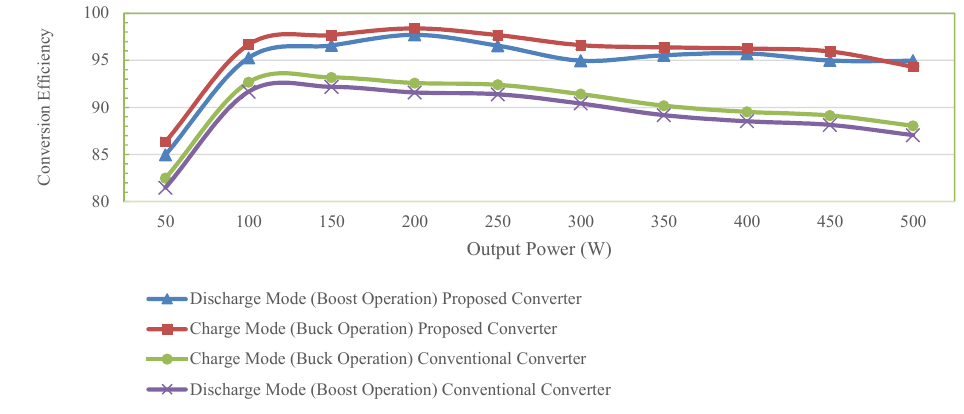
Figure 24. Realized prototype of the proposed converter.